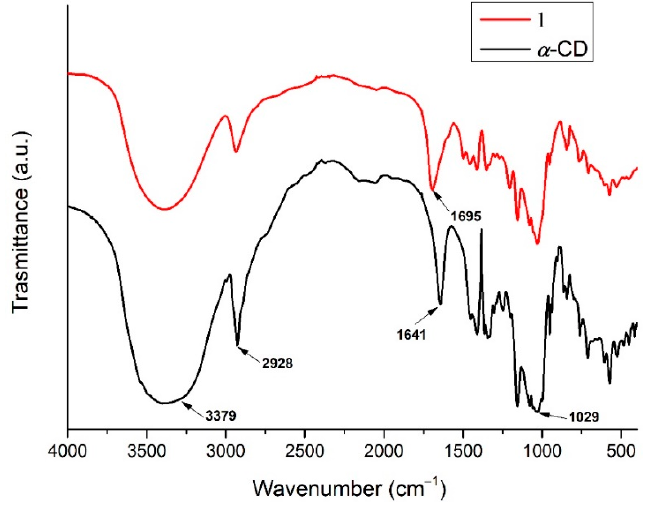
Figure 4. FTIR spectra of α -CD (black curve) and 1 (red curve).